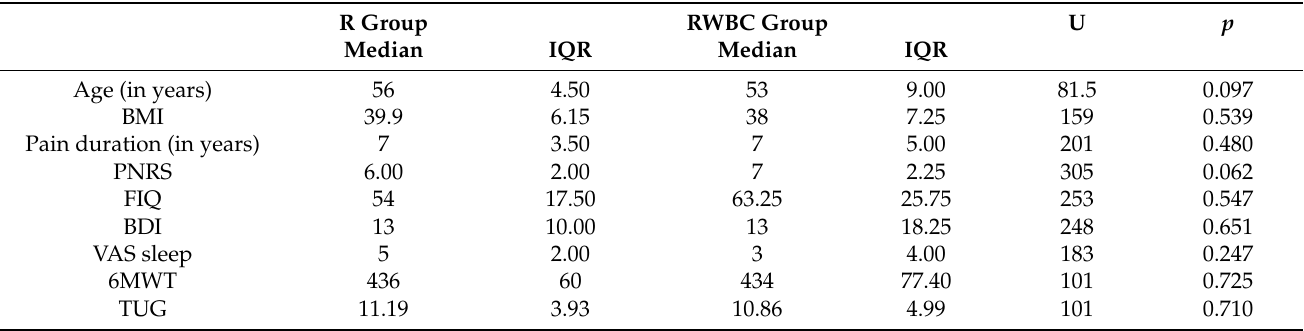
Table 1. Participants’ demographic and clinical characteristics at